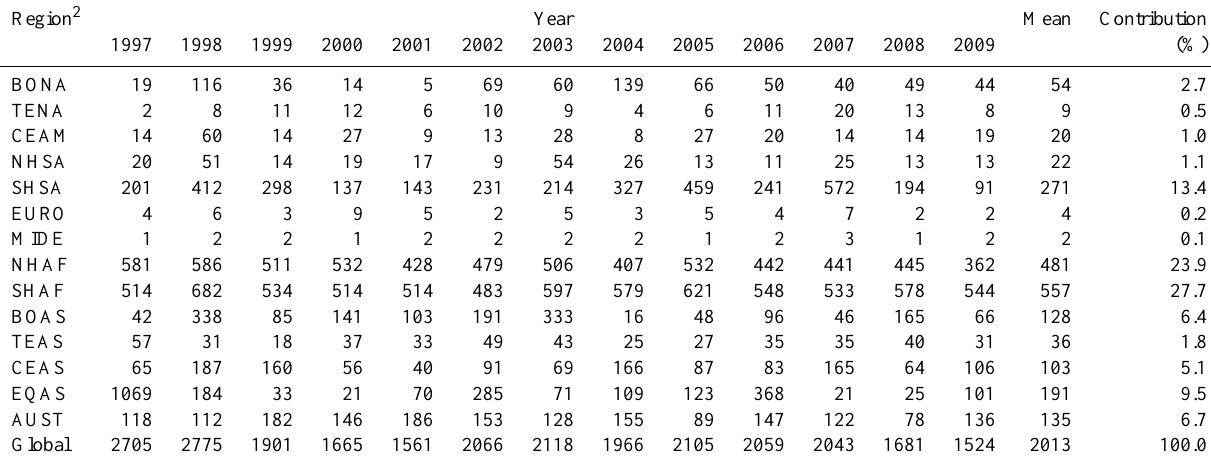
Table 7. Annual emissions estimates (TgCyear − 1 ) over 1997–2009 for different regions 1 . Region 2